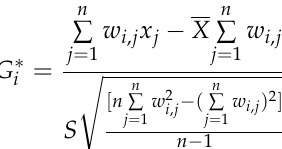
(Figure 3). The Development and Reform Commission of Changning District